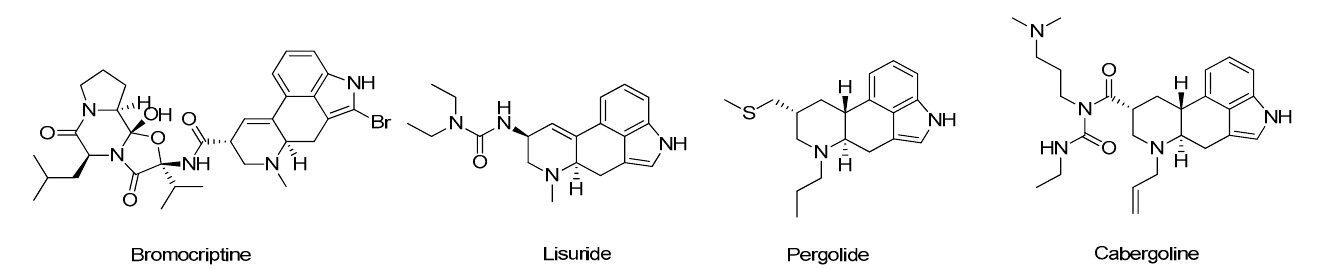
Figure 17. Structures of the ergoline class clinically approved dopamine agonists.